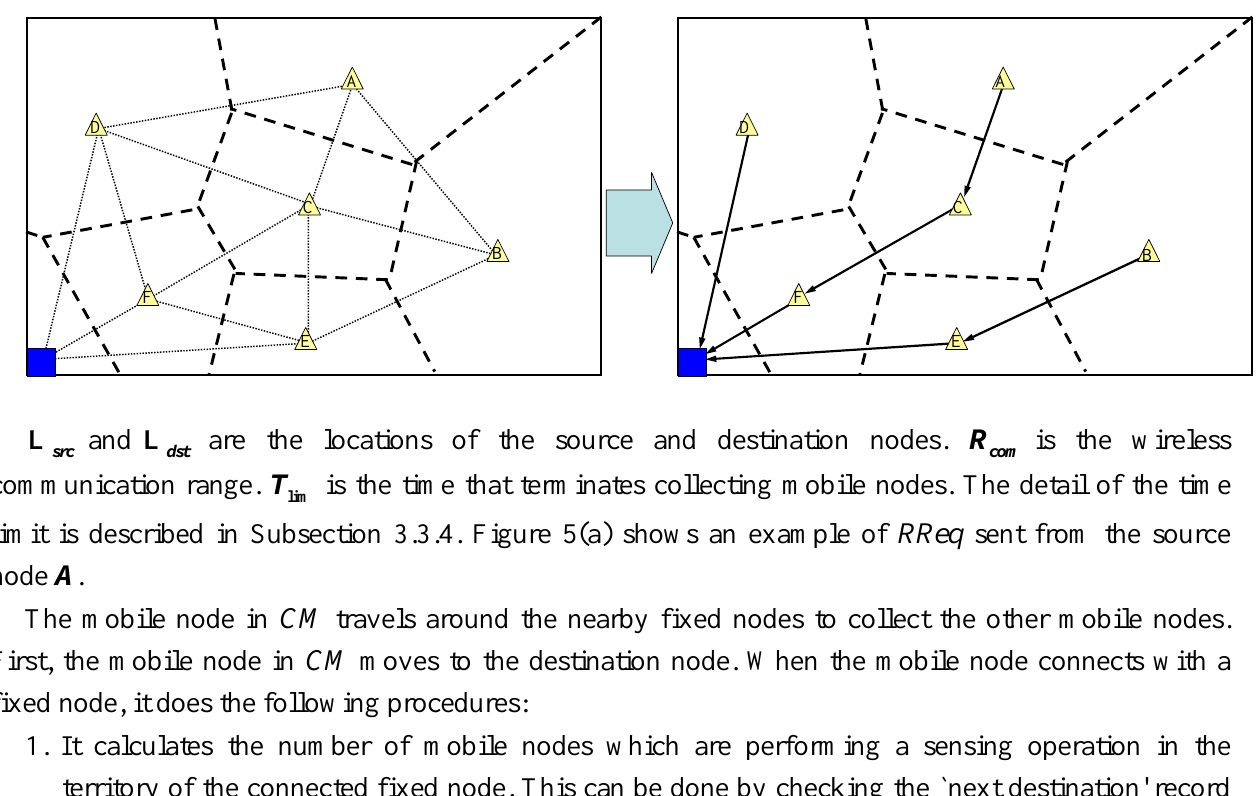
Figure 4. Selection of the next fixed